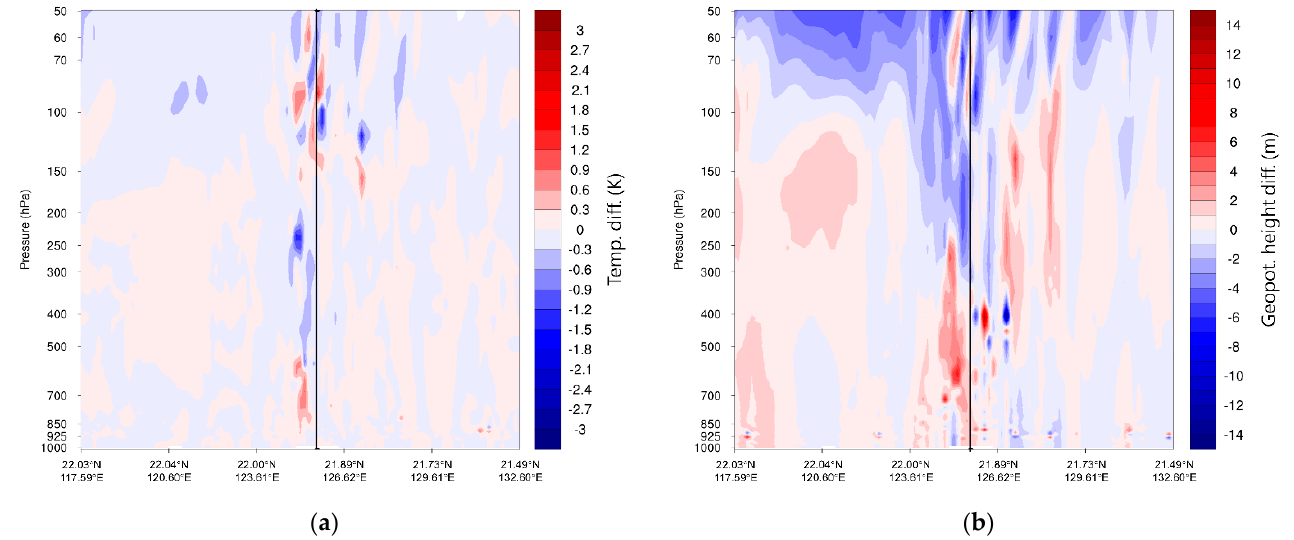
Figure 14. The west–east cross-sections of the ( a ) temperature difference and ( b ) geopotential height difference of WRF Member 2 minus WRF Member 1 at 6 h for the forecast sample initialized at 12:00 UTC 1 August 2020. The cross-sections pass through the typhoon center denoted by the black lines.